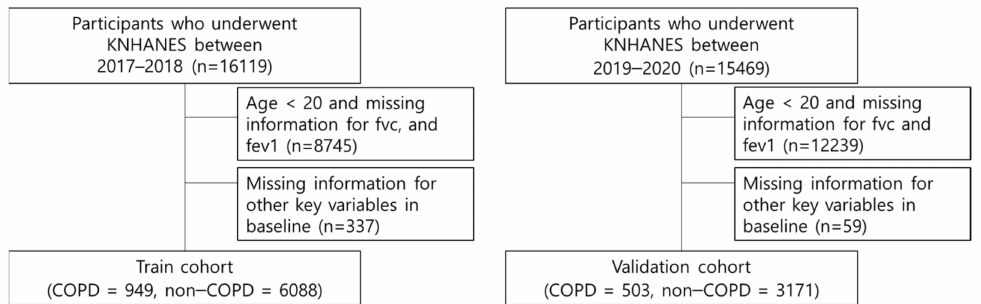
Figure 1. Flow diagram for the inclusion of the study